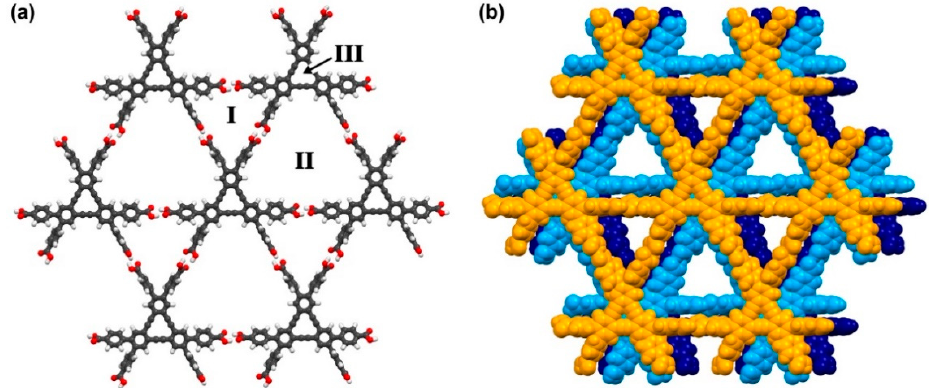
Figure 3. Crystal structure of T12-apo: ( a ) H-bonded HexNet structure; ( b ) LA-H-HexNet.